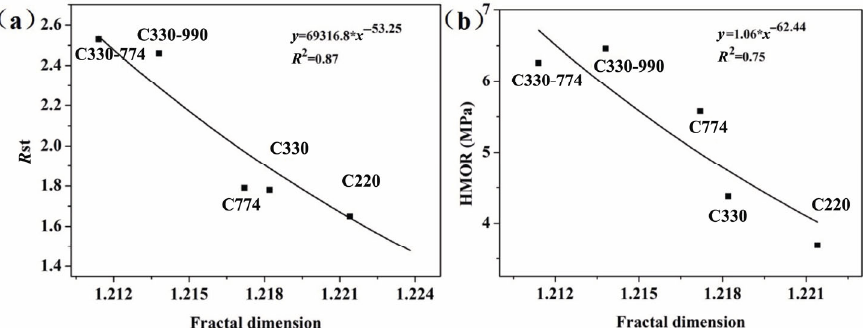
Fig. 8 Relationship between fractal dimension and (a) thermal shock resistance parameters and (b) HMOR.